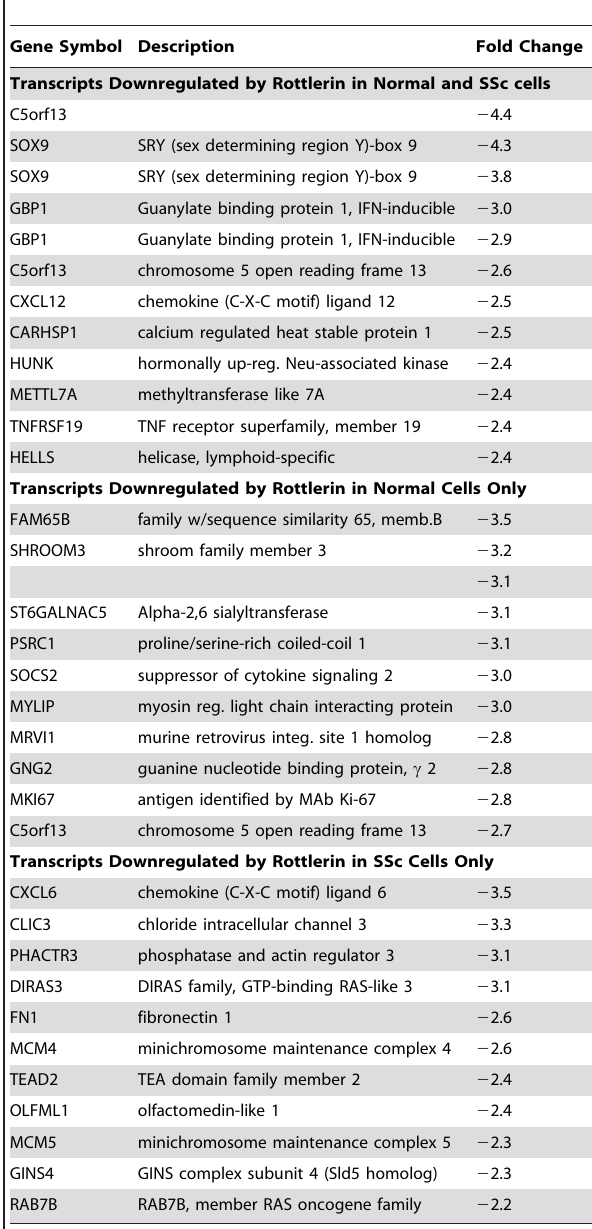
Table 3. Selected downregulated rottlerin responsive transcripts.